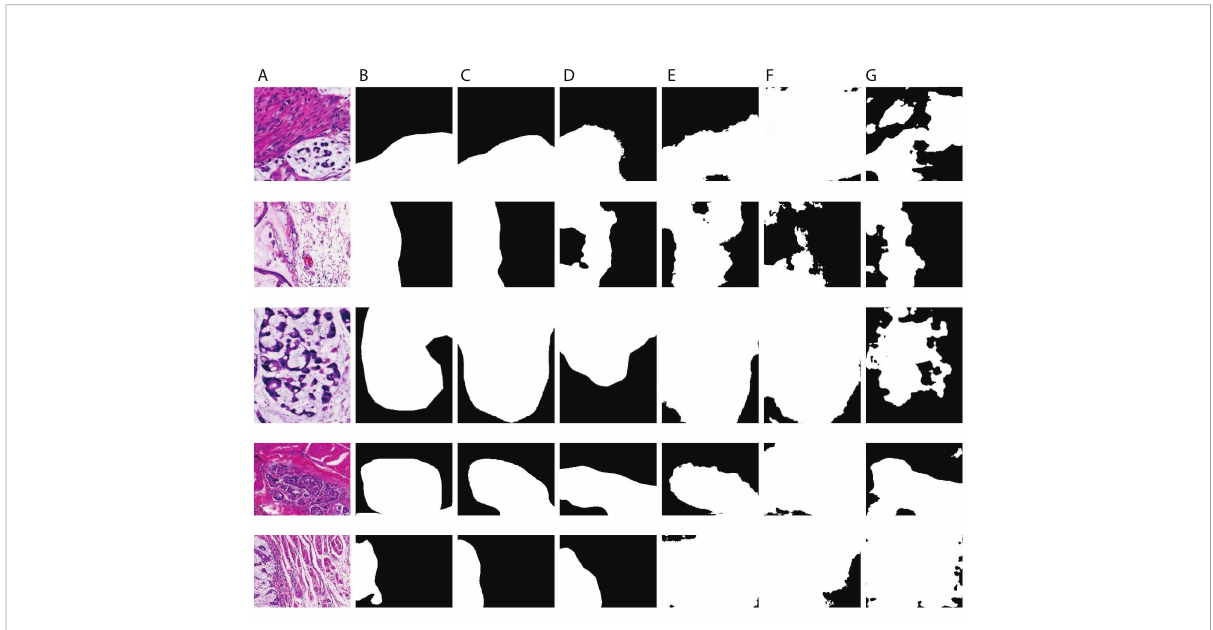
FIGURE 7 Visualization of the results of gastric cancer dectionon SEED dataset. (A) Image; (B) Mask; (C) GCLDNet; (D) PSPNet; (E) LinkNet; (F) U-Net; (G)